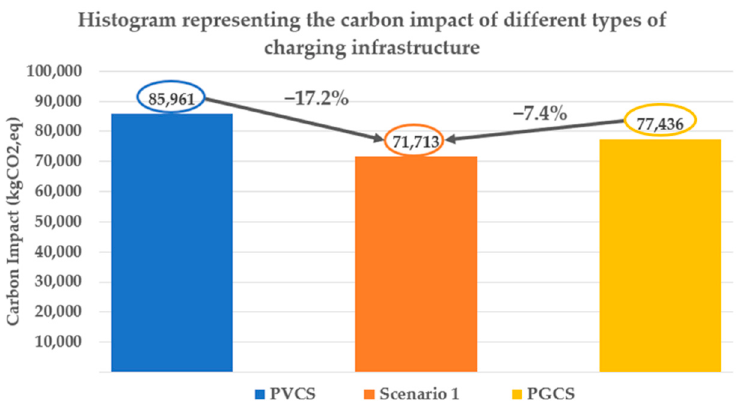
Figure 8. Result of scenario 1.